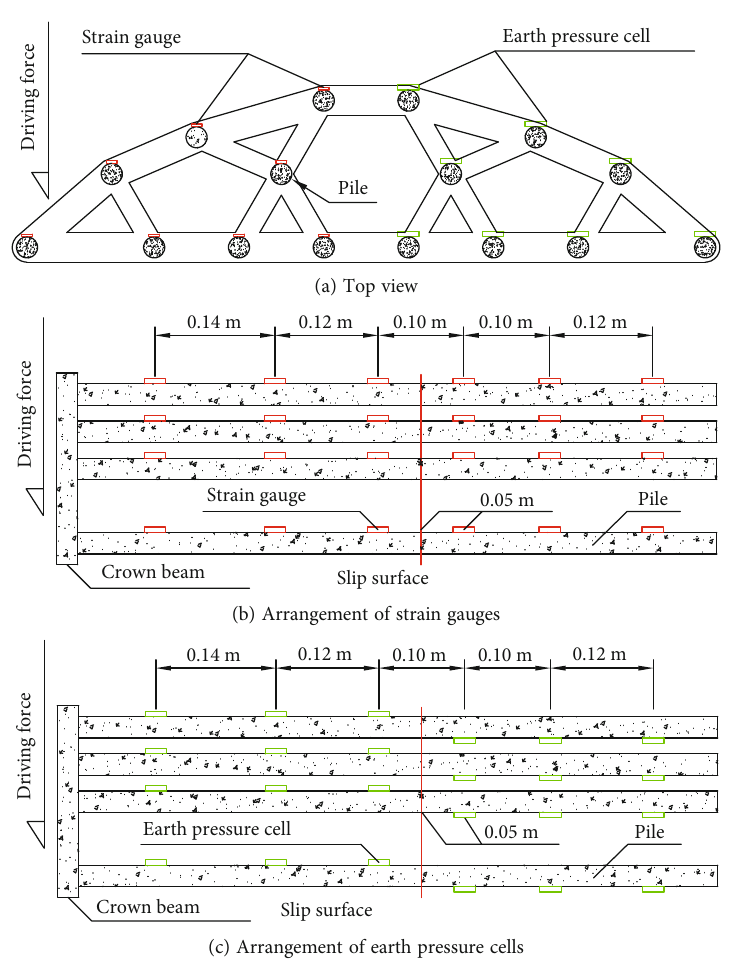
Figure 5: Arrangement of strain gauge and earth pressure cell.